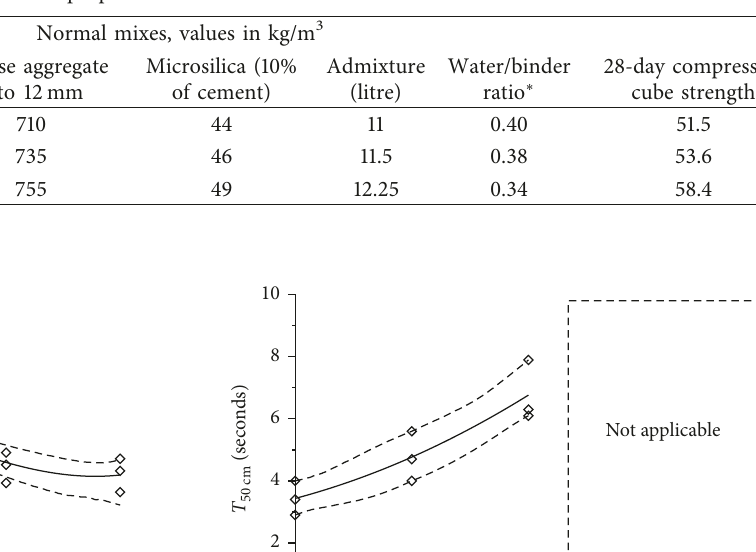
Table 4: Mix proportions of normal concrete mixes.